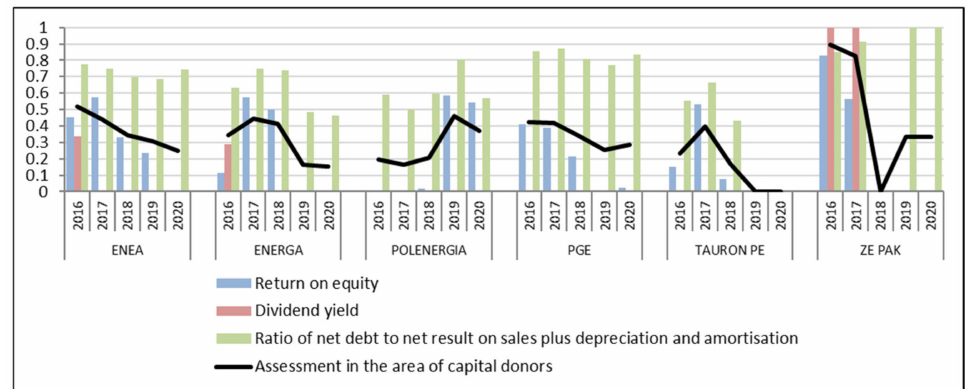
Figure 5. Assessment of the investigated companies’ activities in the area of capital donors.